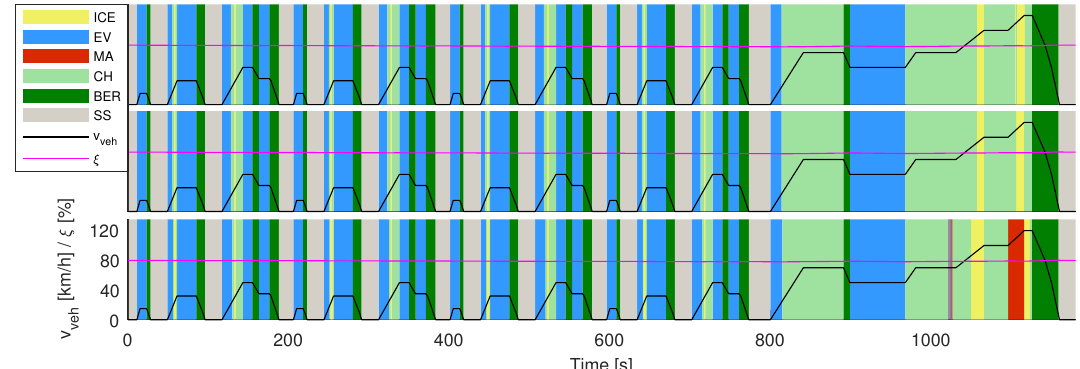
Figure 3. Hybrid mode visualization for three simulation settings on the New European Driving Cycle. ( Top to bottom ) S 0 , S 1 , and S 2 .